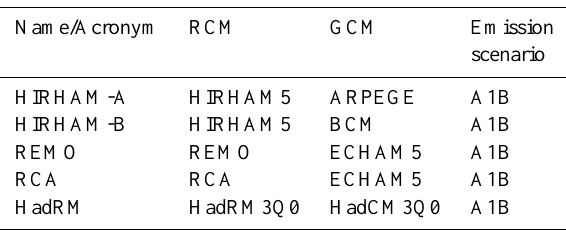
Table 1. Regional climate model (RCM) data used in this study.